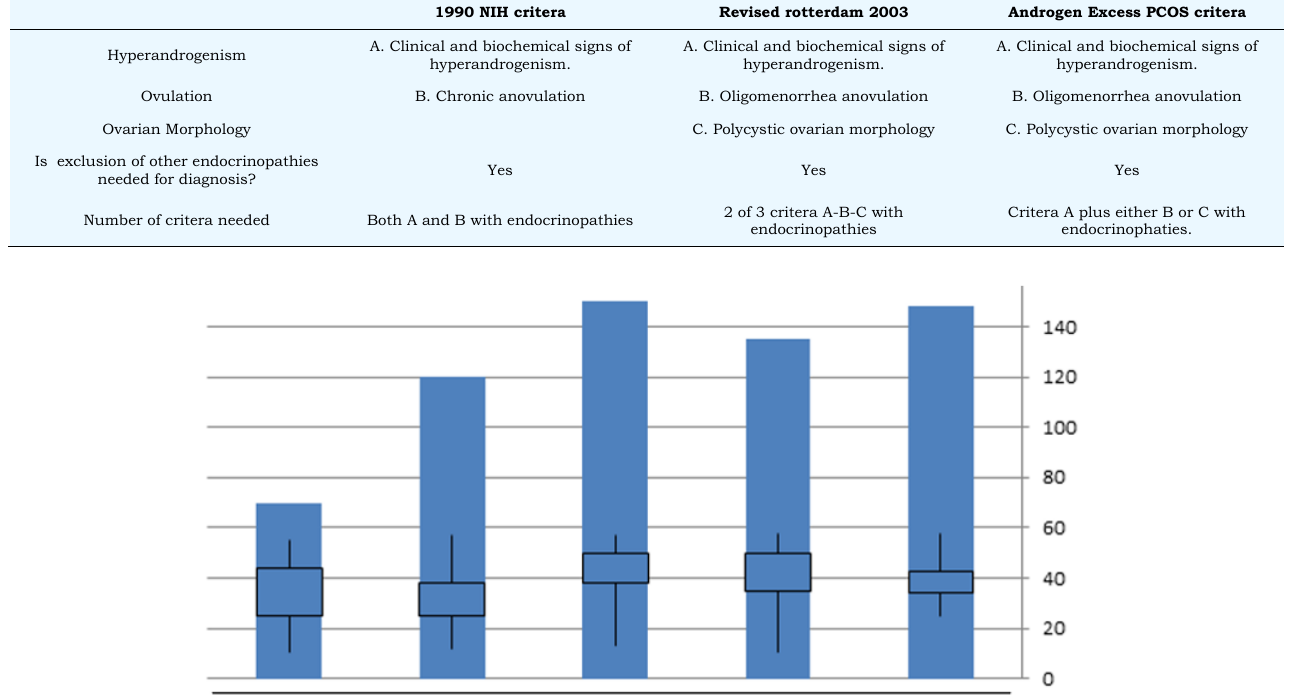
Table 1 Diagnostic criteria for the Polycystic Ovarian Syndrome (PCOS)